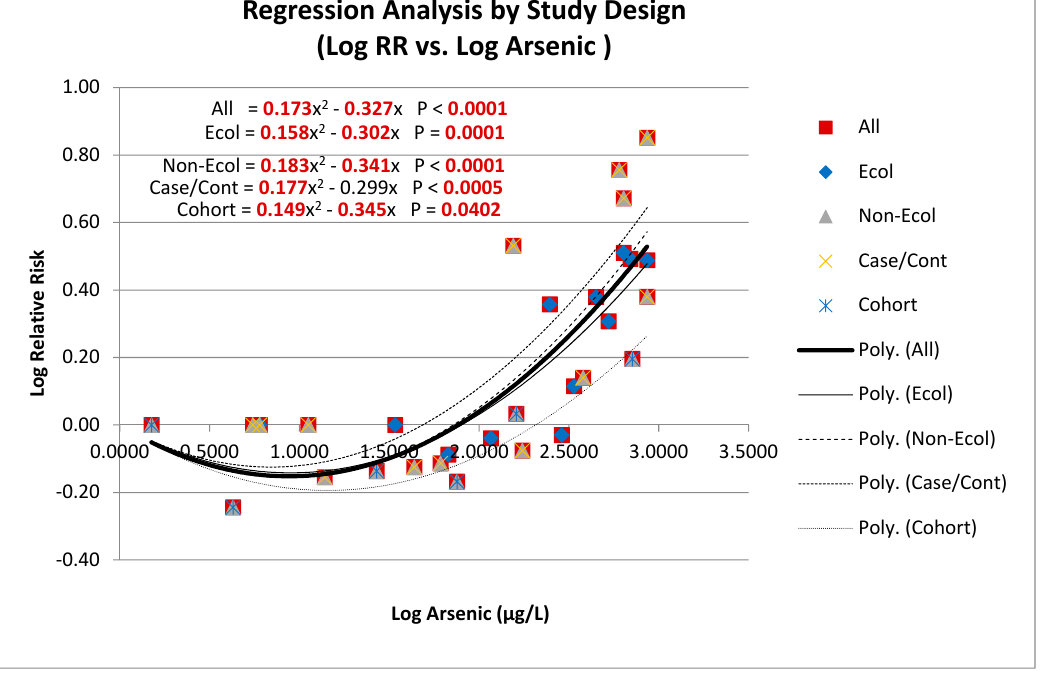
Figure 2. Log relative risk by log arsenic for all study designs.